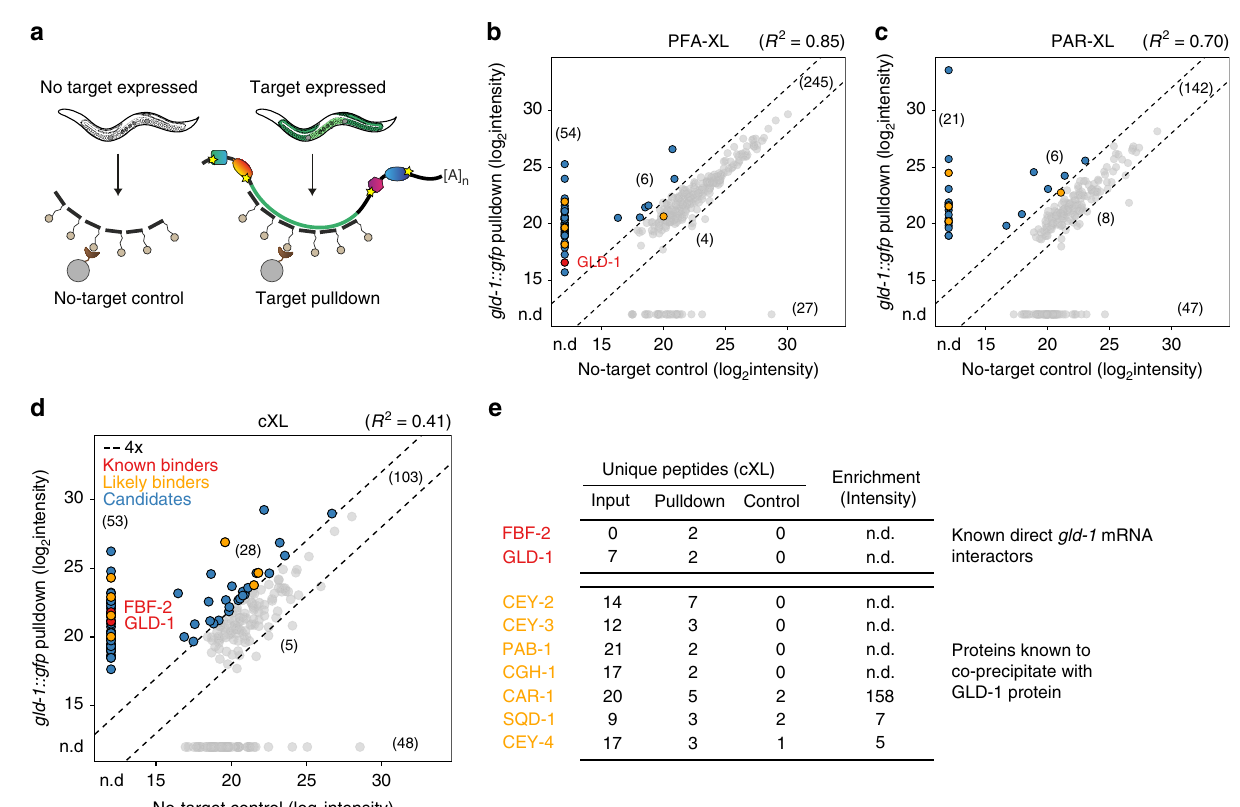
Fig. 2 vIPR with cXL speci fi cally enriches for known interactors of gld-1 mRNA and GLD-1 protein. a To control for unspeci fi c background, vIPR is performed in strains expressing and not expressing the gfp -tagged RNA of interest in an identical manner. b – d vIPR of gld-1::gfp with PFA-XL ( b ), PAR-XL ( c ), and cXL ( d ). Shown are peptide raw intensities from target pulldowns versus corresponding controls. R 2 was calculated for proteins detected in both samples. Numbers in brackets indicate the protein identi fi cations per category. Blue dots denote interaction candidates; red and orange dots denote known and likely interactors of gld-1 mRNA (see e ). n.d., not detected. e Proteins described to interact with either gld-1 mRNA or GLD-1 protein were speci fi cally recovered after pulldown of gld-1::gfp . Red indicates known gld-1 mRNA regulators 19,25,26 , orange indicates proteins that were consistently found to co-precipitate with GLD-1 protein 32,33 . Shown are numbers of unique peptides identi fi ed in input, target pulldown and no-target control, as well as speci fi c protein enrichment in pulldown versus no-target control, based on peptide intensities. See also Supplementary Data 2 for detected and enriched